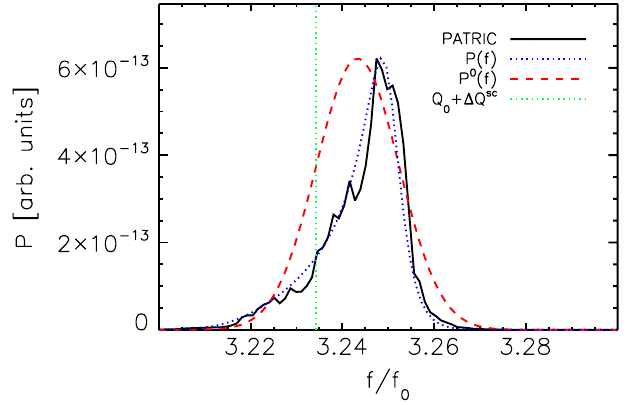
FIG. 5. (Color) Noise spectrum from the PATRIC simulation with self-consistent space charge. The space charge parameter is (cid:4) 1 . The dashed red curve represents the noise spectrum U sc (cid:4) 0 with its maximum adjusted to the U for U sc The vertical green line represents the shifted tune Q (cid:4) Q (cid:2) Q sc